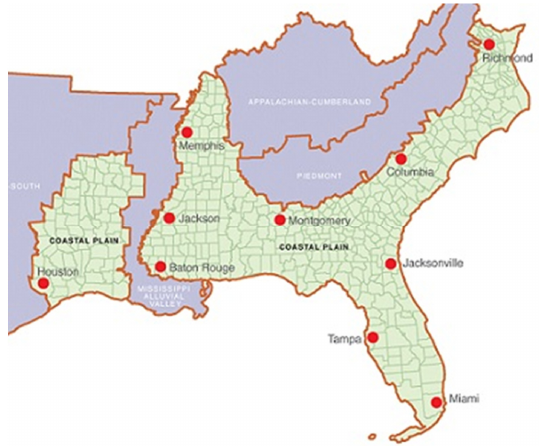
Figure 1. The coastal plain of Southeastern United States. Adapted from Hoyle, S. CompassLive—Klepzig, K., R. Shelfer, and Z. Choice. 2016. Forests of the South’s Coastal Plain: The next 50 years. USDA Forest Service. Asheville, NC. Forests 2021 , 12 , x